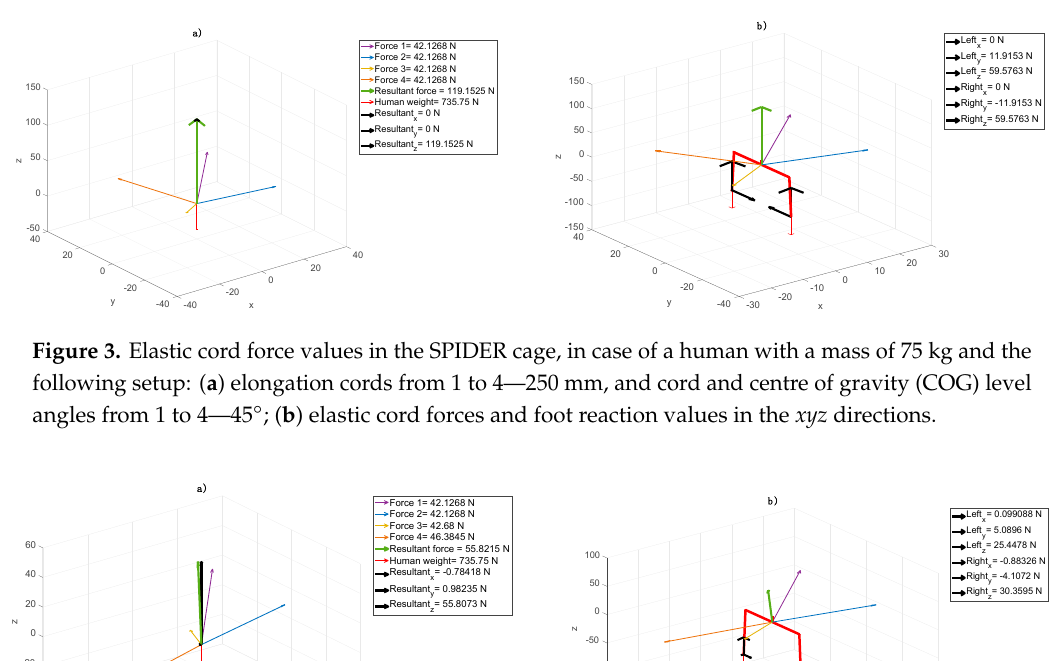
Figure 4. Elastic cord force values in the SPIDER cage in case of a human with a mass of 75 kg and the following setup: ( a ) cord elongations 1 and 2 - 250 mm, 3 - 240 mm, and 4 - 310 mm; COG level angle cords 1 and 2 - 45°, 3 - 6°, and 4 - 48°; ( b ) elastic cord forces and foot reaction values in the xyz directions.